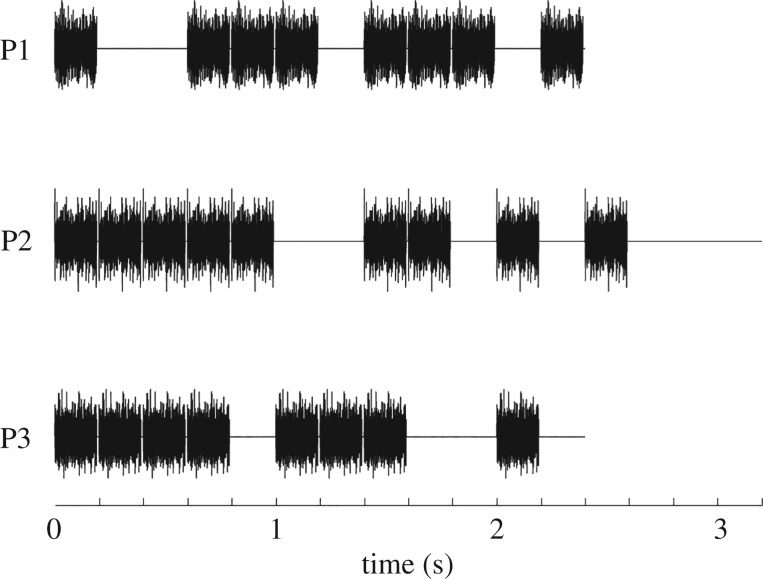
An illustration of the rhythmic patterns P1–P3, from top to bottom. The slowest tempo (1×) is illustrated for each pattern where each event was 200 ms in duration. In the experiment, P1 was played at tempi of 1×, 2× and 4×; P2 at 1×, 2× and 3×; and P3 at 1×.